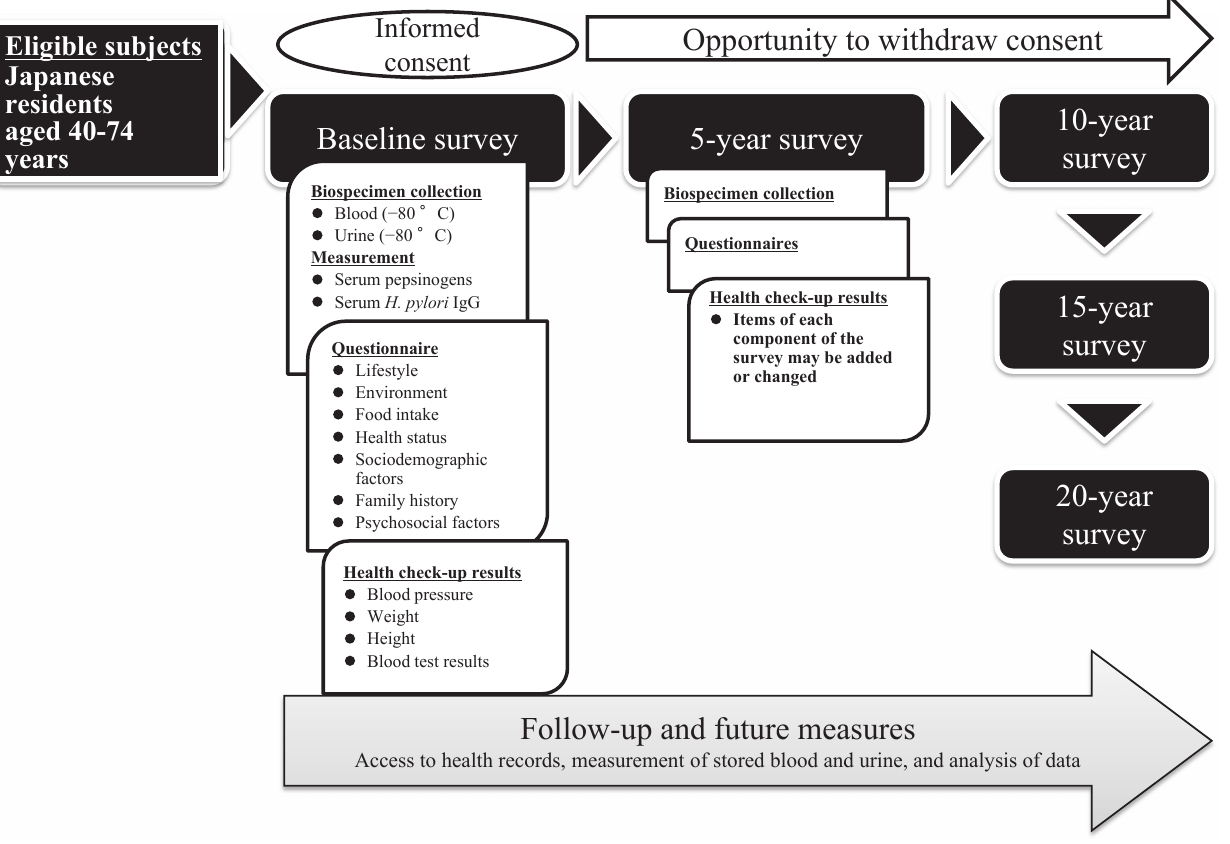
Figure. Components of surveys in a cohort study according to the standard protocol. Study components include the baseline, which includes the collection of biospecimens and measurements, questionnaires, and health check-up results. The follow-up and biorepository period will be 20 years from enrollment. Every 5 years from the baseline survey, the same type of cross-sectional survey will be performed. Survey items may be added or revised according to medical developments that occur following the baseline